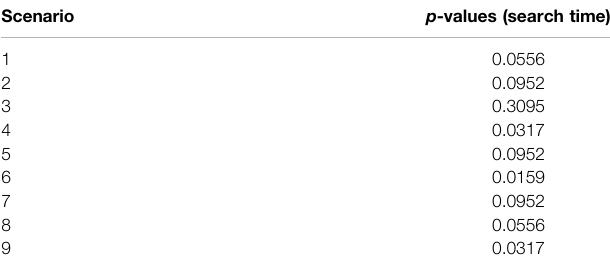
TABLE 7 | Table of p -values for Wilcoxon rank sum test results to compare the Search Time between the PSOP and D* Lite algorithms. The null hypothesis is thatboth datasetsaresamplesfromcontinuous distributions